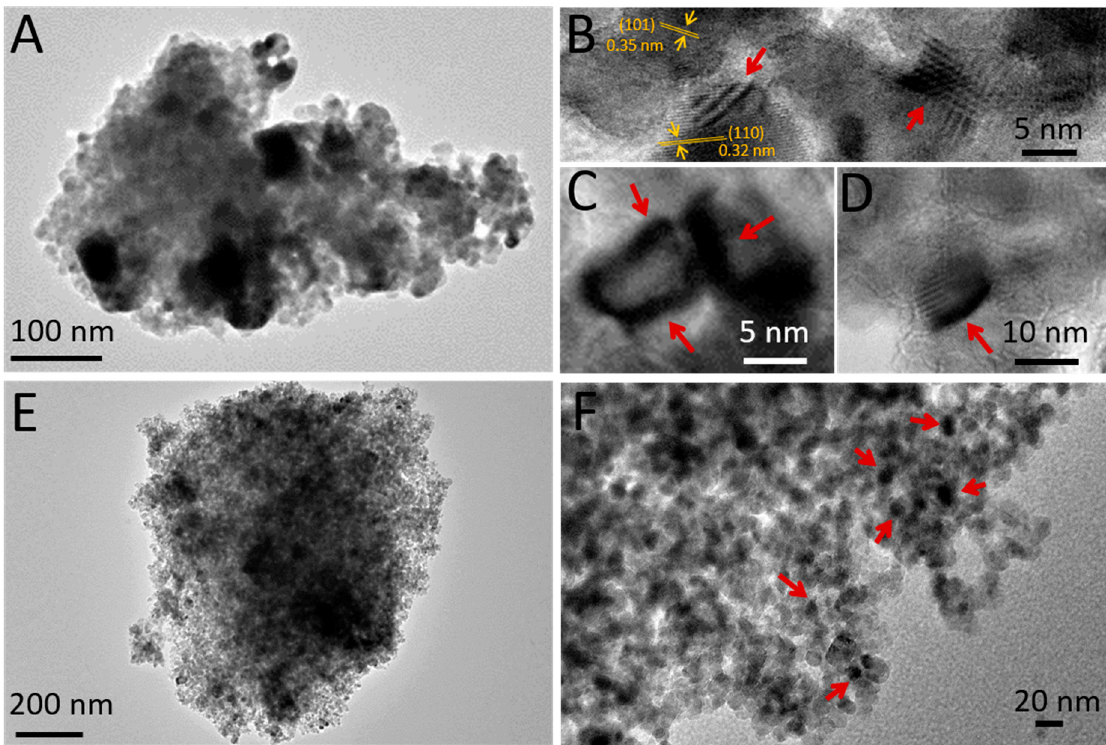
Figure 5. Representative TEM images of Ru@TiO 2 -sg ( A – D ) and Ru@TiO 2 -ns ( E , F ). Red arrows indicate the epitaxial growth of RuO 2 crystallites over rutile-TiO 2 -sg ( B – D ) and formation of Ru clusters with an average diameter of 15–20 nm over TiO 2 -ns ( F ).